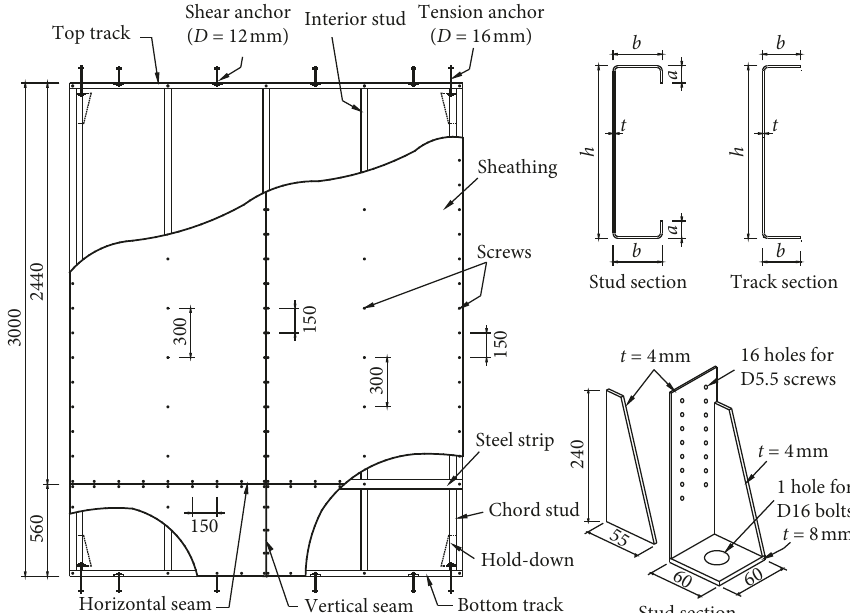
Figure 1: Details of specimen configurations.